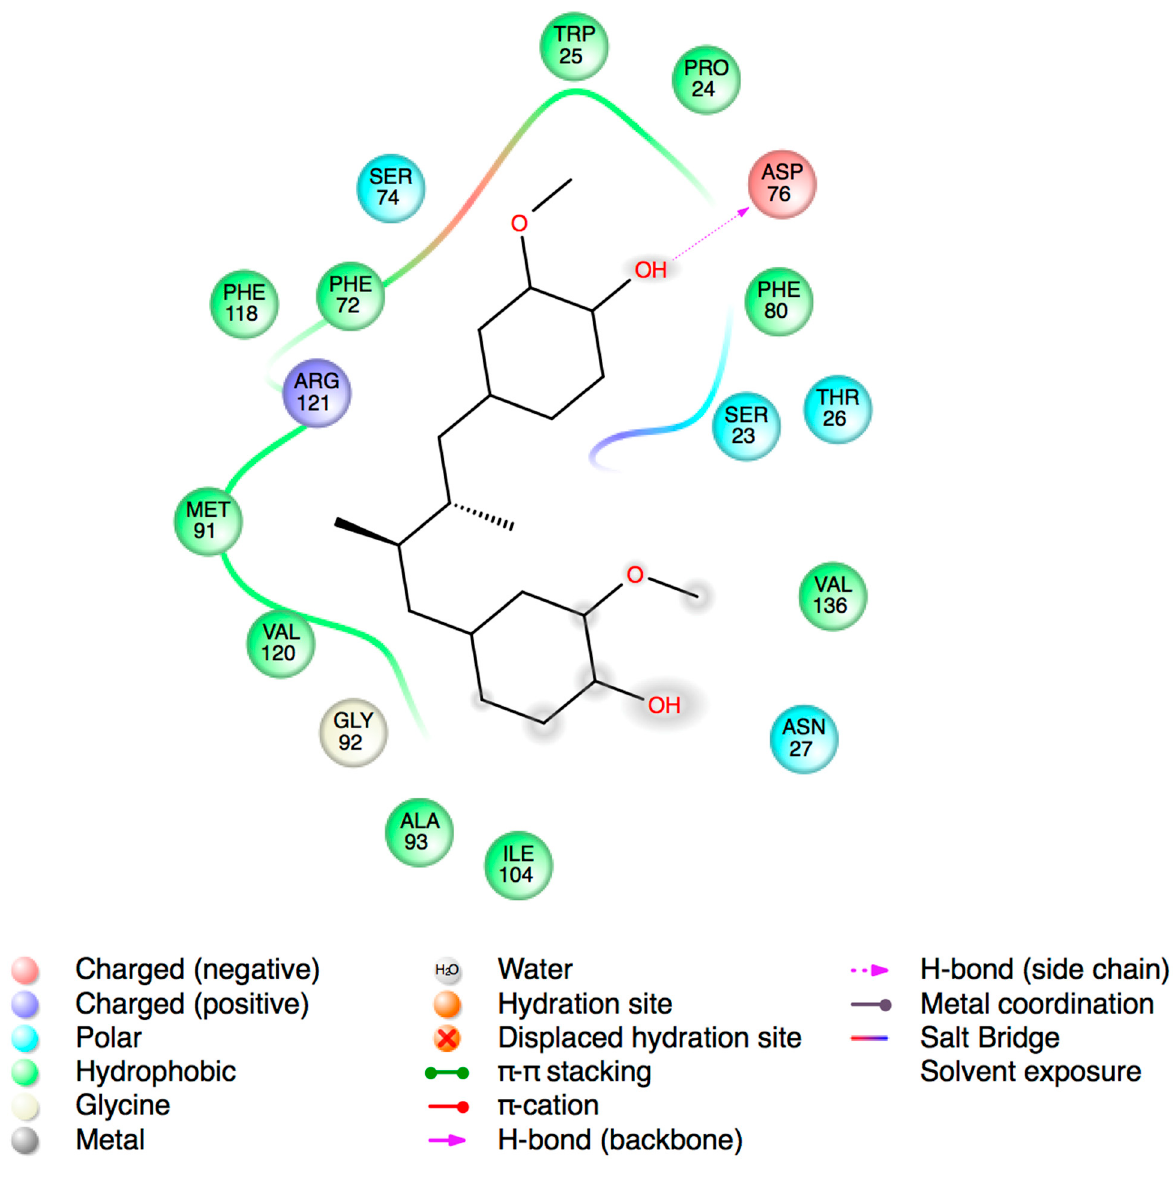
Figure 4. Predicted interactions of the MDGA molecule on the CoAt-Mt binding site by docking studies. The segmented lines represent hydrogen bond and its distance and the residues with red lines means interactions by Van der Waals contacts. This figure was created with the Free Maestro program